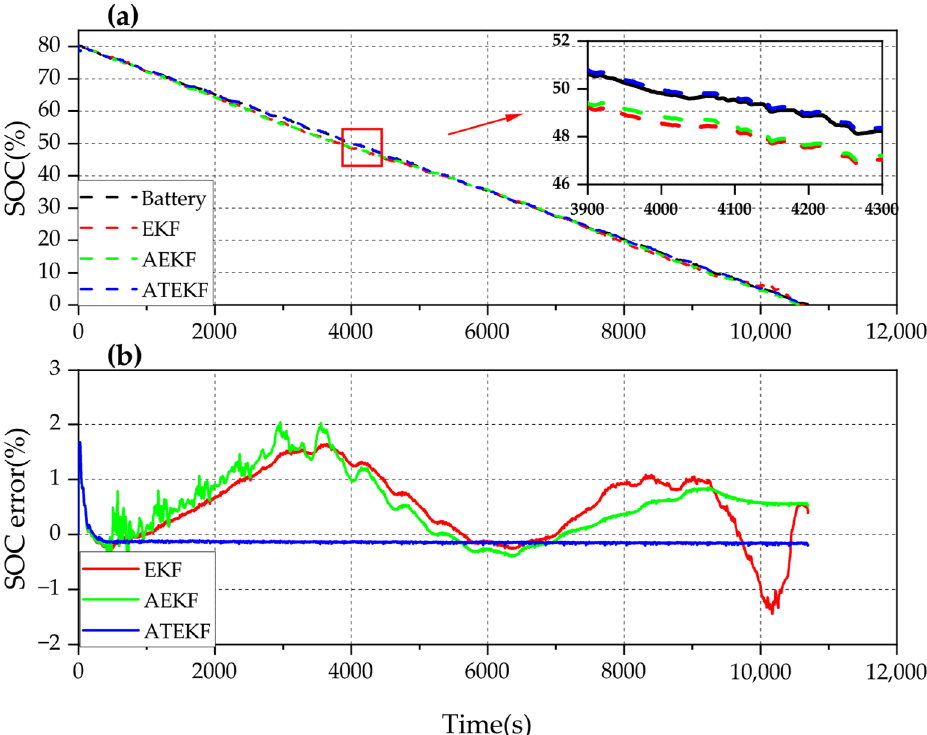
Figure 10. US06 under 25 °C: ( a ) actual SOC, prediction of EKF, AEKF, and ATEKF; ( b ) SOC error comparison of EKF, AEKF, and ATEKF.